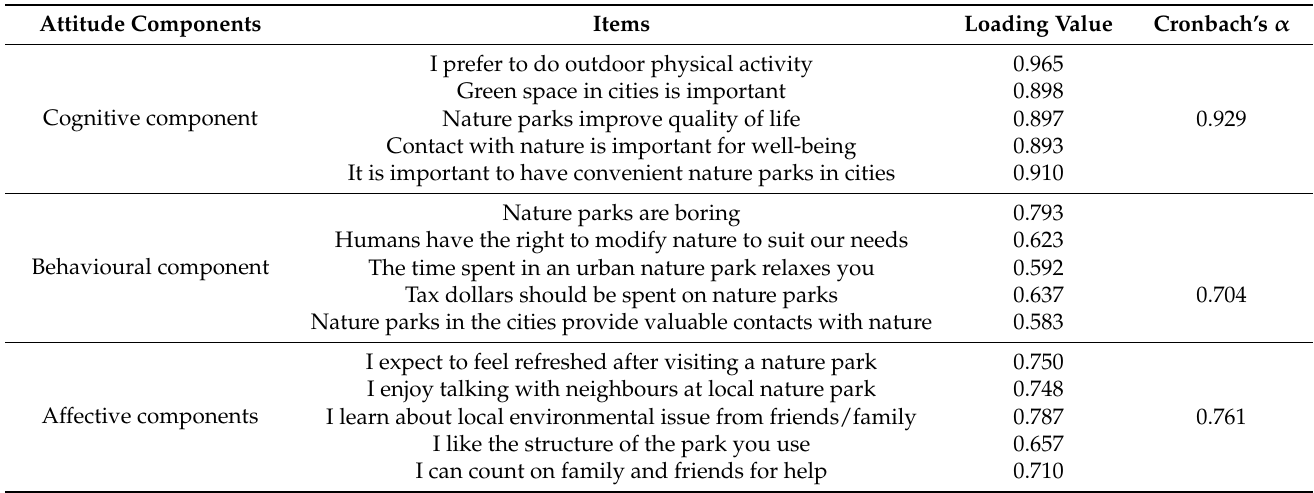
Table 1. Reliability